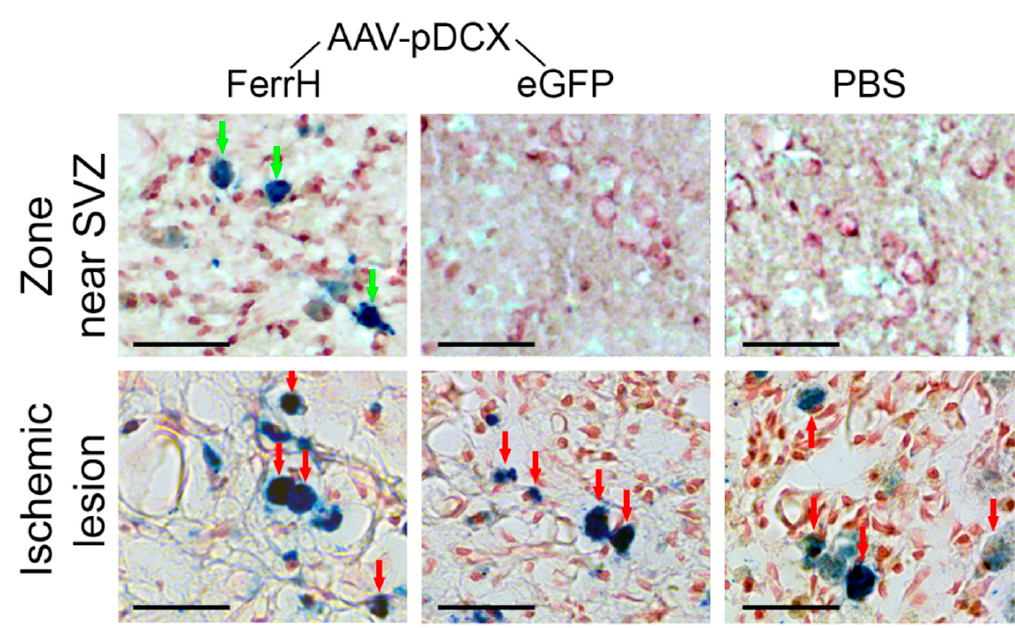
Figure 6. Perl’s Prussian blue histological staining for detection of iron accumulation in the zone near lateral ventricle and SVZ (top row) and in the ischemic lesion zone (bottom row). Green arrows point to the cells with iron accumulation in the zone near the SVZ; red arrows point to the cells with iron accumulation in the ischemic lesion. Scale bar corresponds to 50 µm. Abbreviations: AAV, adeno-associated viral backbone; pDCX, doublecortin promoter; FerrH, ferritin heavy chain; eGFP, enhanced green fluorescent protein; PBS, phosphate-buffered saline; SVZ, subventricular zone. Figure 7a illustrates typical colocalization of FerrH- and eGFP-positive cells with the markers of mature (NeuN) and young (DCX) neurons in animals after MCAO in the brain zone near the lateral ventricle and SVZ outside ischemic lesion. Similar types of colocalization was observed in sham-operated